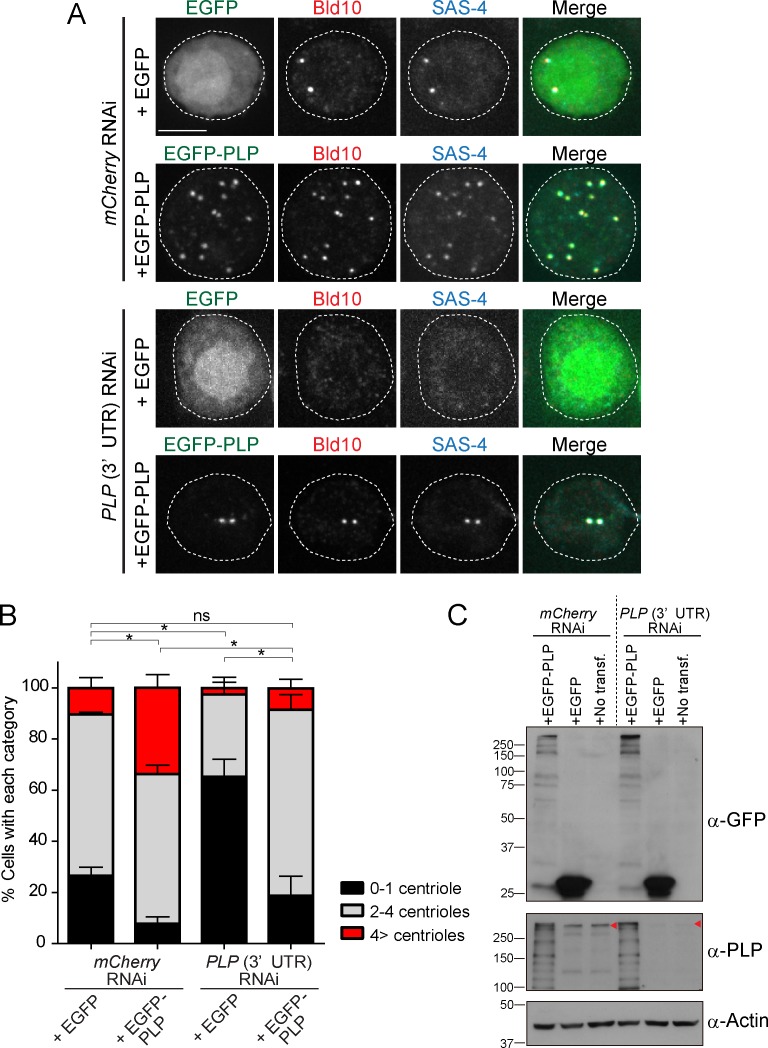
Expression of full-length PLP rescues centriole number defects in PLP-depleted cells.(A) Images of interphase D.Mel cells expressing EGFP-tagged full-length PLP or only EGFP after depletion of endogenous PLP by RNAi. D.Mel cells were depleted of PLP (PLP 3’UTR RNAi) (mCherry RNAi was used as negative control) for three days for two rounds. Cells were immunostained with anti-Bld10 (red) and SAS-4 (cyan). Scale bar, 5 μm. (B) Quantification of centriole number per cell (N > 50) in EGFP-positive cells shown in A. Data are the average of three experiments ± s.d (ns, not significant, *p<0.05, Mann-Whitney U test performed for the 0–1 centriole category). (C) Western blotting analysis of in the cells shown in A using the antibodies against GFP, PLP and actin (loading control). Red arrowheads indicate expected bands of the longest PLP isoform.10.7554/eLife.41418.023Figure 6—figure supplement 2—source data 1.The source data to plot the graph in Figure 6—figure supplement 2B.